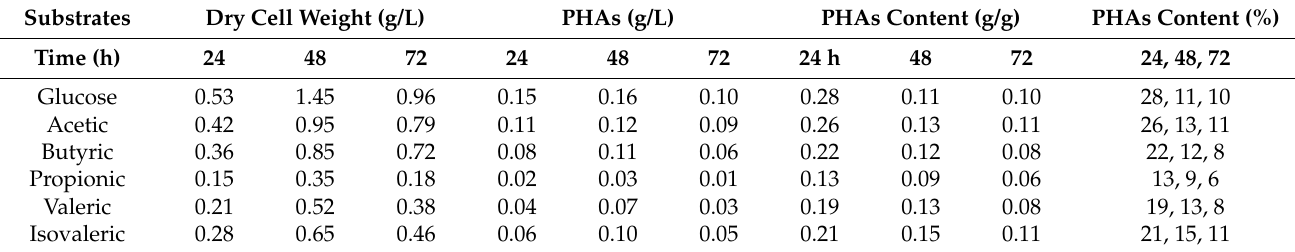
Table 1. Dry cell weight and PHAs accumulation by P. oleovorans in synthetic VFAs media.